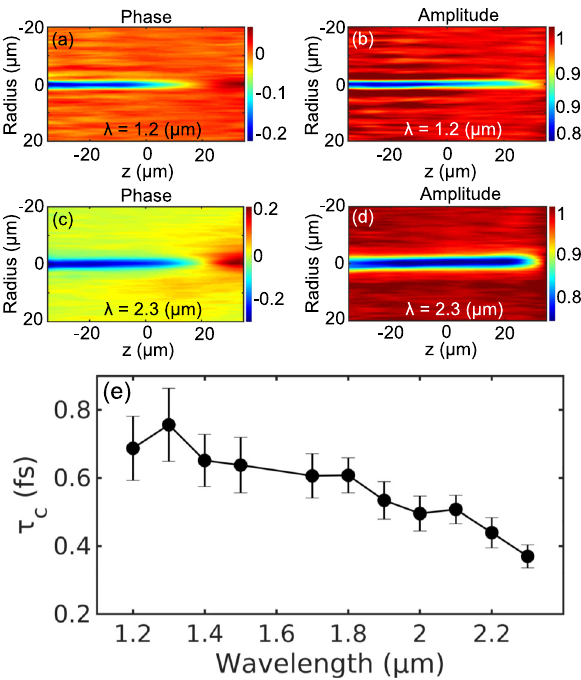
Fig. 2 Measurement of the electron collision times in fi lament-produced plasma. Examples of two-dimensional pro fi les of phase and electric fi eld absorption (normalized probe electric fi eld amplitude) during fi lamentation for a , b 1.2 μ m and for c , d 2.3 μ m measured by single-shot femtosecond time-resolved interferometry. e Measured electron collision time versus wavelength. The error bars in e correspond to the standard deviation of 35 laser